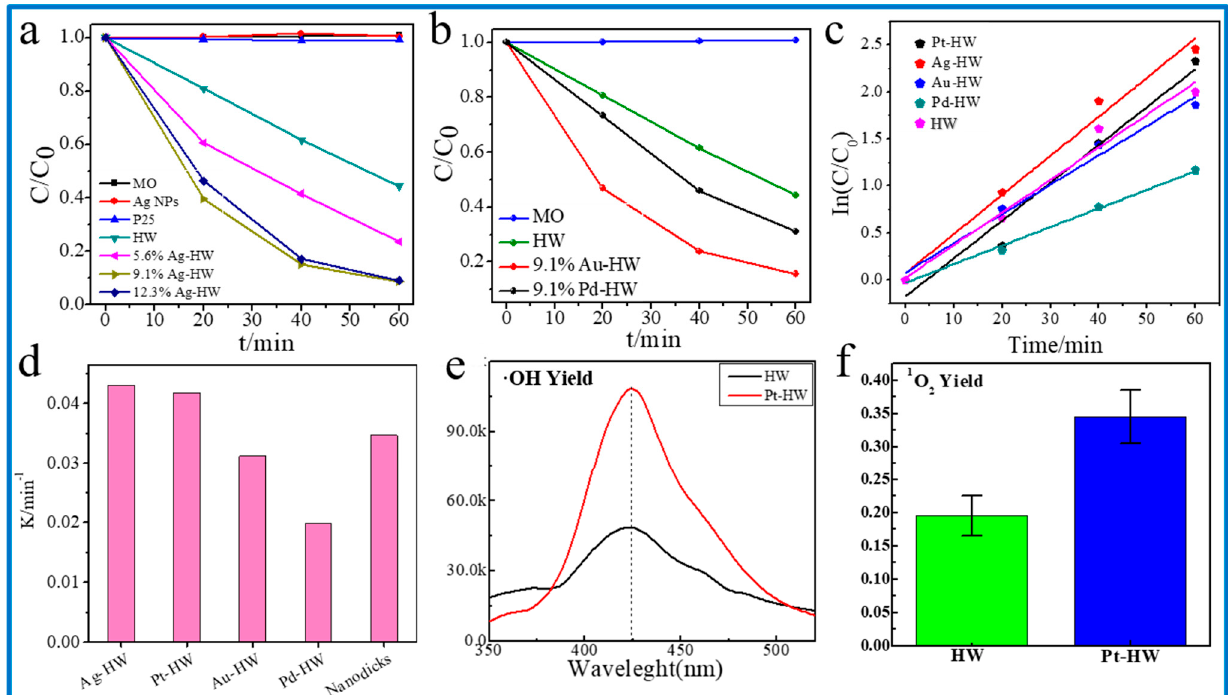
Figure 7. The degradation curves of MO with different metal loadings: ( a ) Ag-HW; ( b ) Au-HW; and Pd-HW. Comparison of rate constants of MO degradation using different composites at the same metal loading: ( c ) kinetics curves; ( d ) rate constants. The reactive oxygen species (ROS) yields of Pt-HW and HW under light irradiation: ( e ) hydroxyl radicals (·OH); ( f ) singlet oxygen ( 1 O 2 ).